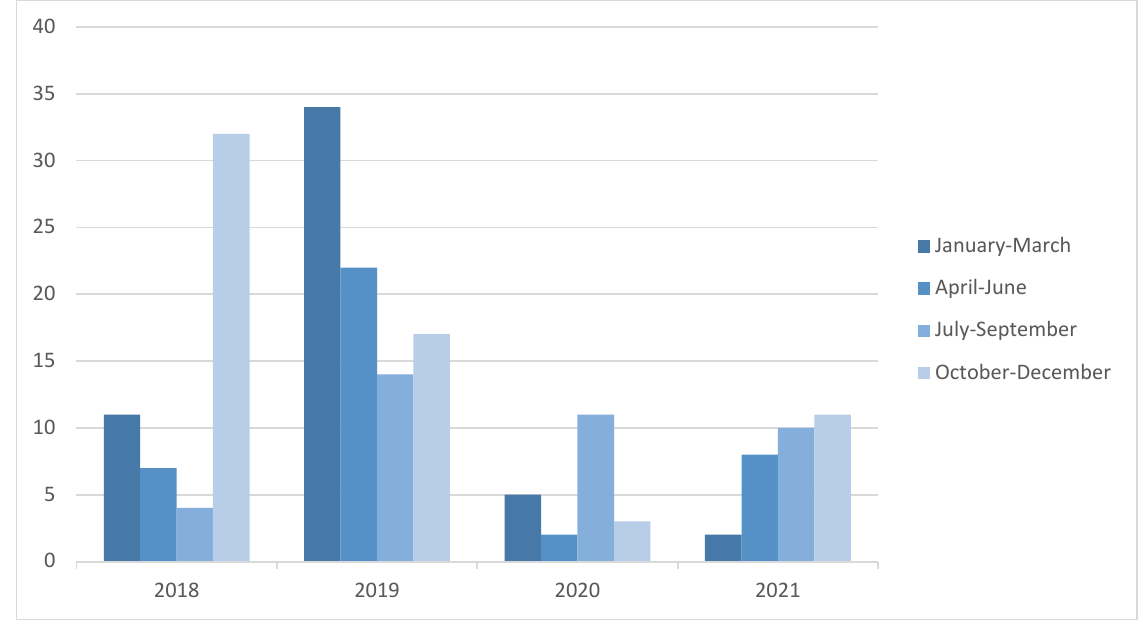
Figure 1. Number of unaccompanied minors screened by year and trimester.